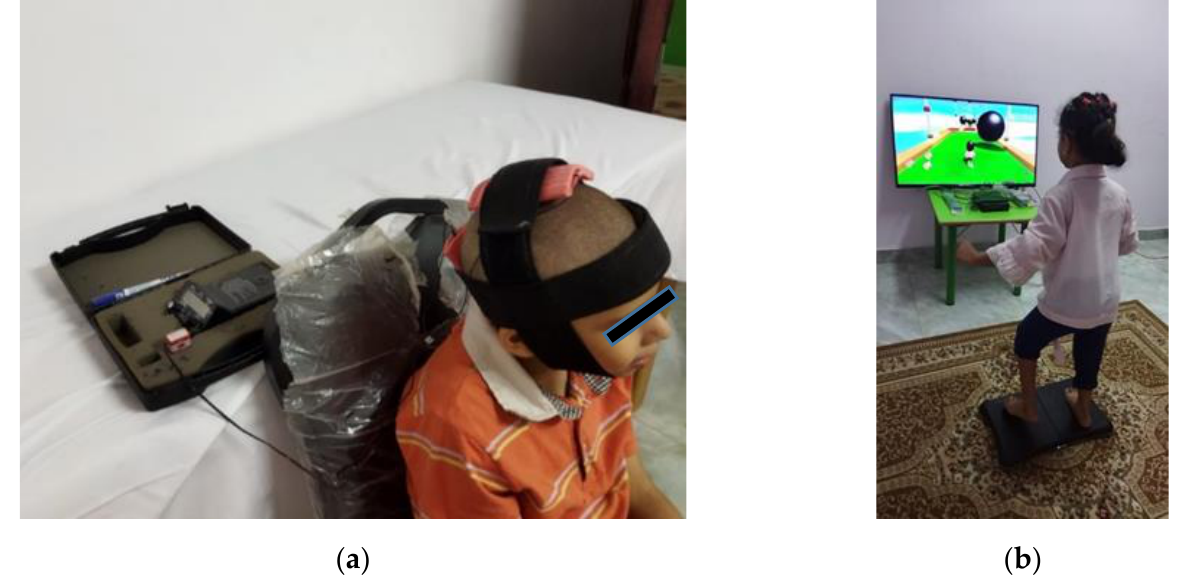
Figure 2. Experimental setup for ( a ) tCDS, including electrode position; ( b ) VR balance training, including an example obstacle course game.